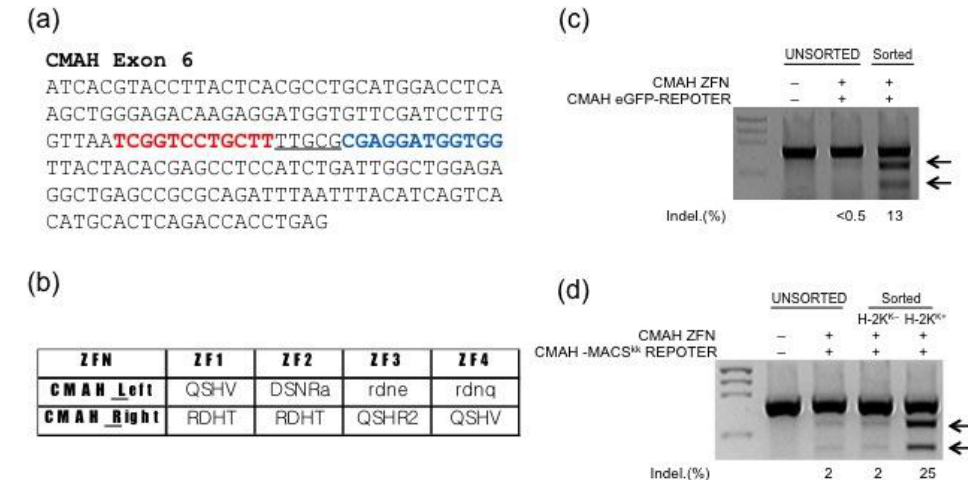
Figure 1. Enrichment system for cells containing ZFN-mediated mutations. (a) Sequences of the ZFN binding sites in the CMAH gene. The binding site of the right (red letters) and left (blue letters) ZFNs and the spacer sequence (underlined) are indicated. (b) The zinc finger module composition of CMAH ZFNs. (c and d) ZFN-driven CMAH mutations detected by the T7E1 assay in cell populations isolated by FACS (c) and MACS (d) using a ZFN surrogate reporter. H-2K k , a truncated mouse MHC class I, is used a selection marker for MACS. Arrows indicate the expected positions of DNA bands from specific cleavage of a mutated site by the mismatch-sensitive T7E1 enzyme. The numbers at the bottom of the gel indicate mutation percentages calculated by band